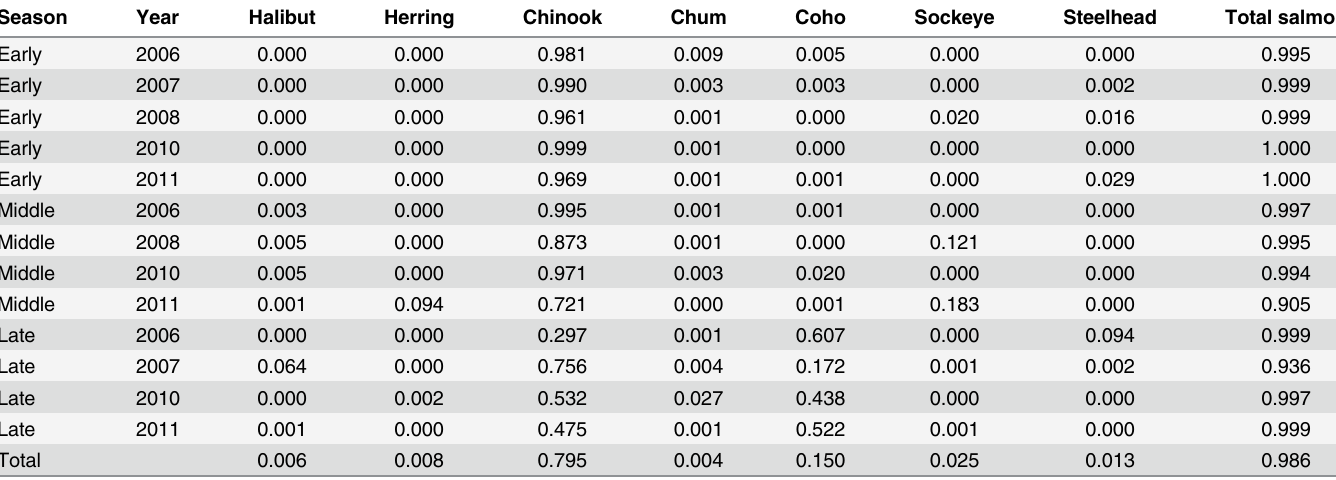
Table 4. Proportion of DNA sequences from potential prey species sequenced from killer whales fecal samples * .